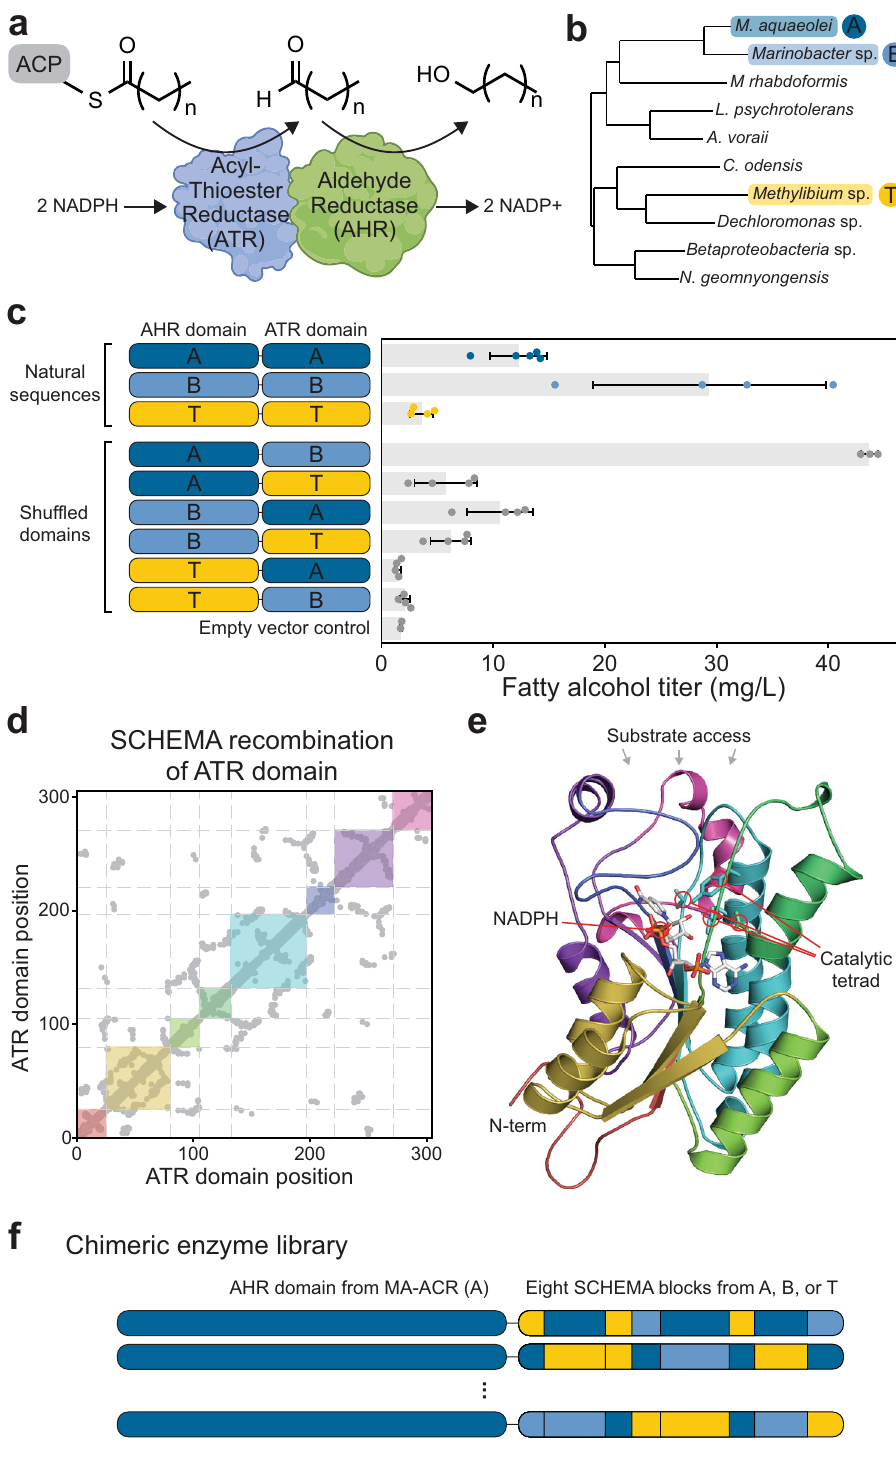
Fig. 1 Acyl-ACP reductase activity of natural and chimeric enzymes. a Alcohol-forming acyl-ACP reductases consist of two domains that sequentially reduce acyl-ACP substrates to aldehydes, and then aldehydes to alcohols. b We focused our studies on three diverse sequences from M. aquaeloei (dark blue) , Marinobacter BSs20148 (light blue), and Methylibium Sp. T29 (yellow), which we refer to as A, B, and T, respectively. c Total fatty alcohol production by the three natural sequences and the six chimeric enzymes generated by shuf fl ing their AHR and ATR domains. The error bars represent one standard deviation centered at the mean of four replicates ( n = 4) from cultures derived from individual colonies, except for MA-ACR (where n = 5), parent B (fusion A-B, where n = 3) and the empty vector ( n = 2). d ATR domain residue-residue contact map used for SCHEMA recombination. The colored squares depict the eight sequence blocks from the SCHEMA design that minimize structural disruption. e The SCHEMA blocks mapped onto the ATR domain ’ s three-dimensional structure (the colors correspond to the squares in ( d )). f Our chimeric ATR library was fused to the AHR domain from MA- ACR. Source data underlying Fig. 1c are provided as a Source Data fi